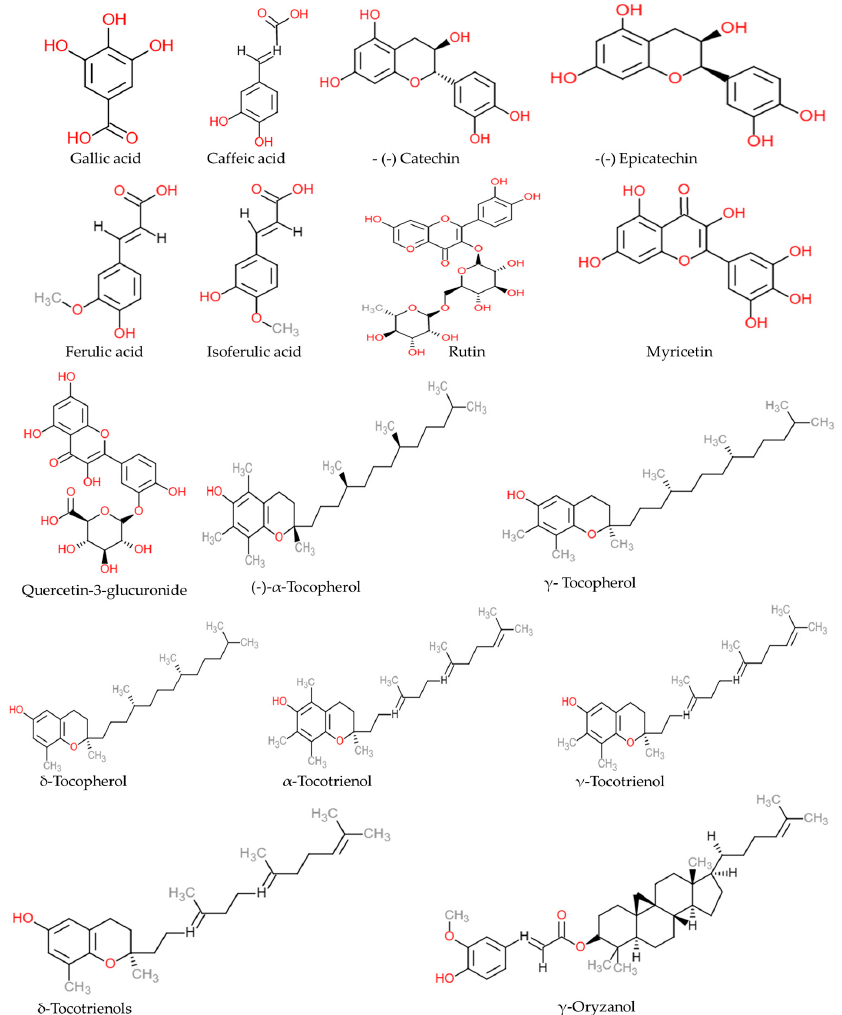
Figure 1. The representative major phytochemicals present in rice bran. Chemical structures were drawn using free online ChemDoodle Web software (https://web.chemdoodle.com/demos/2dsketcher, accessed on 28 February 2023).